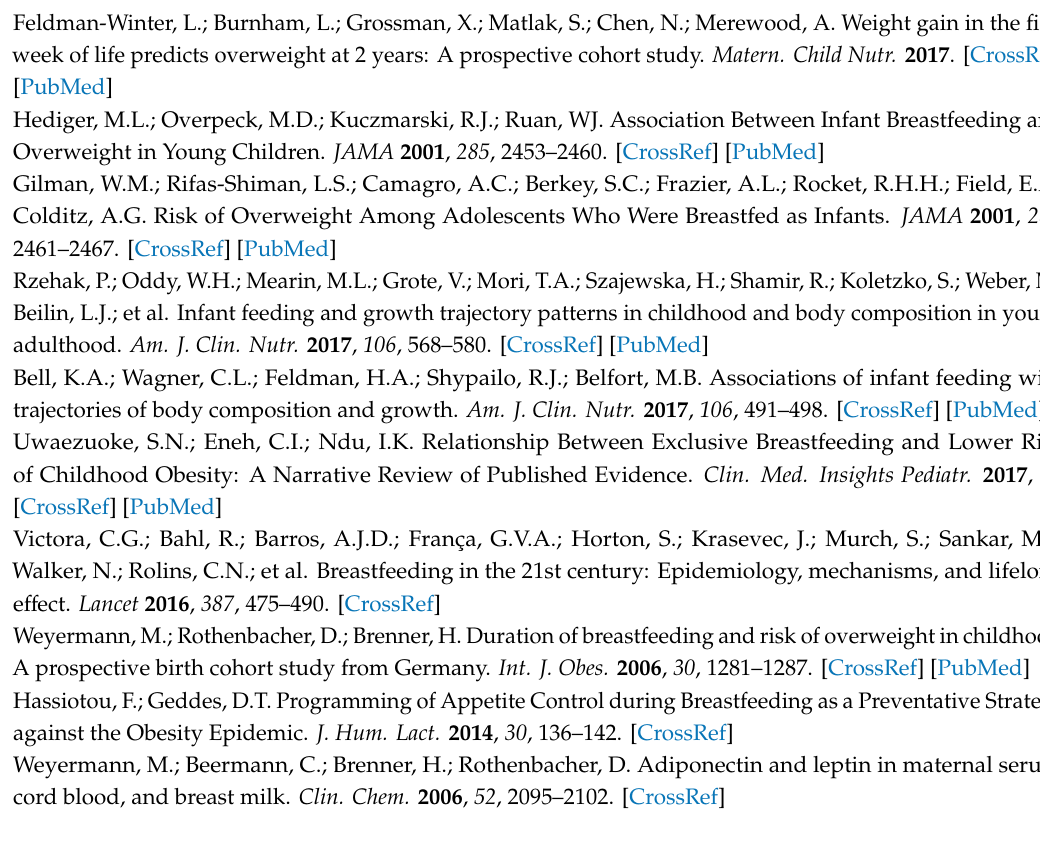
Figure S1: Distribution of leptin concentrations ( µ g / l) in human milk samples collected at six weeks in the UBCS and SPATZ cohort studies., Figure S2: Distribution of non-standardized log-transformed and standardized leptin concentrations ( µ g / l) in human milk samples collected at six weeks in the UBCS and SPATZ cohort